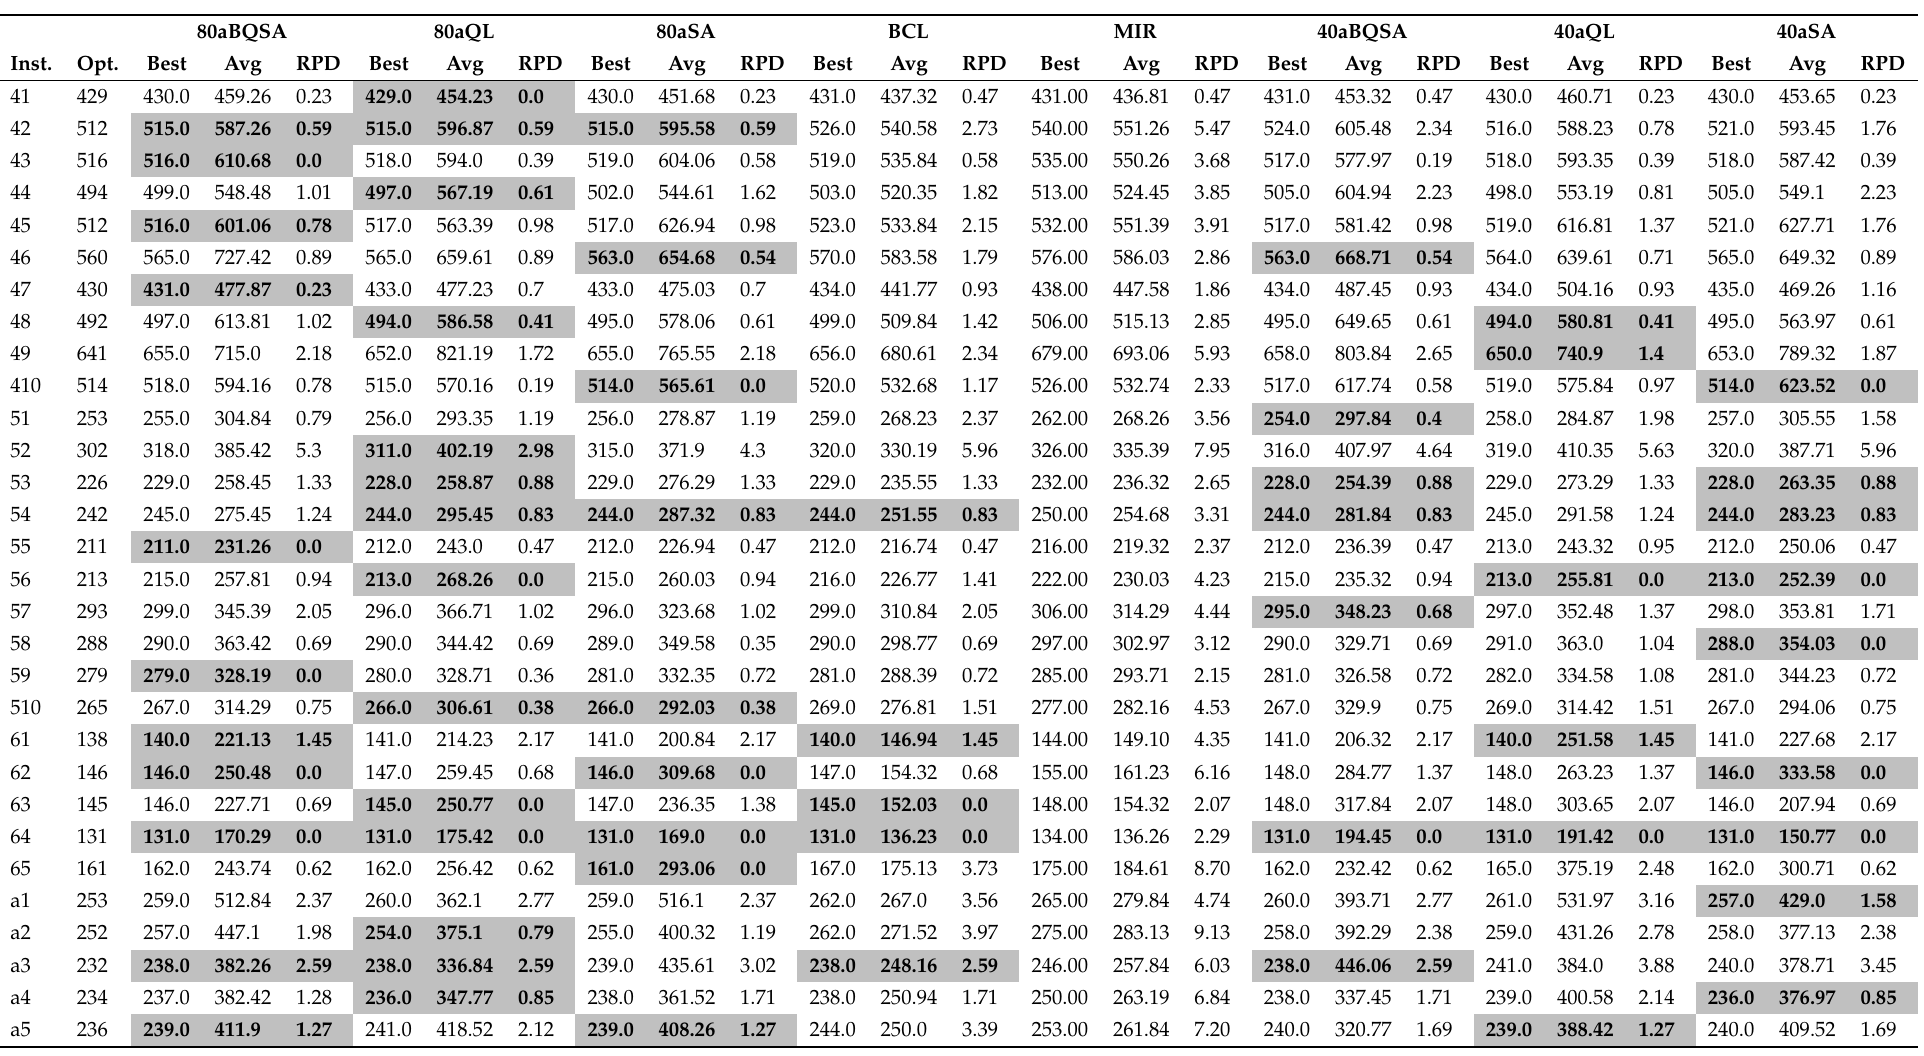
Table 3. Comparison of the metaheuristics’